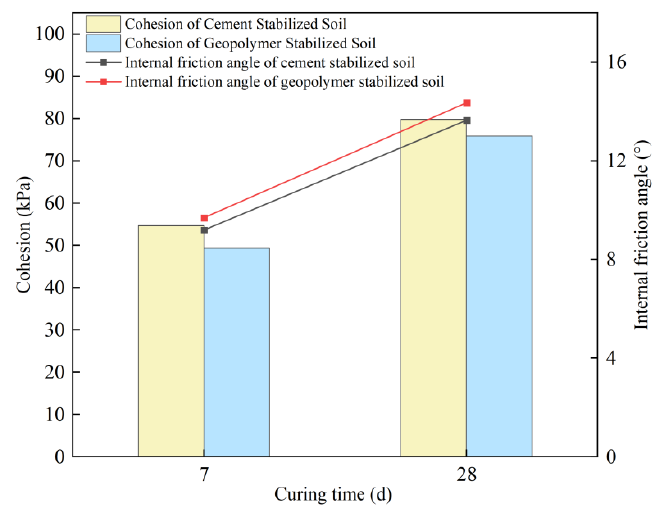
Figure 5. Shear resistance of the soil stabilized by geopolymer and OPC